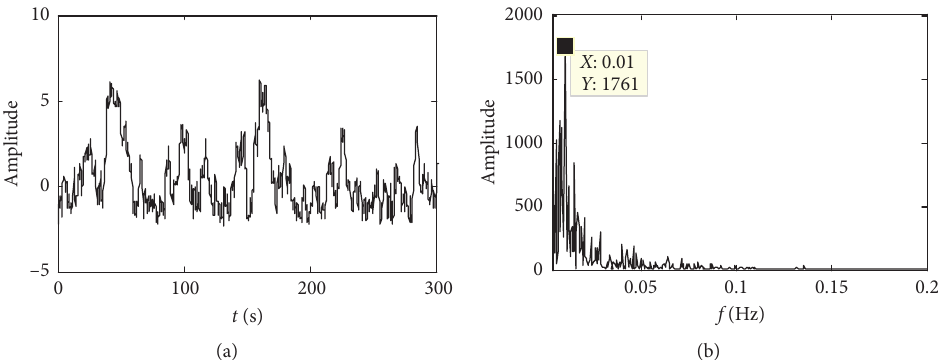
Figure 4: Time-domain and frequency-domain graphics of input and output signals.